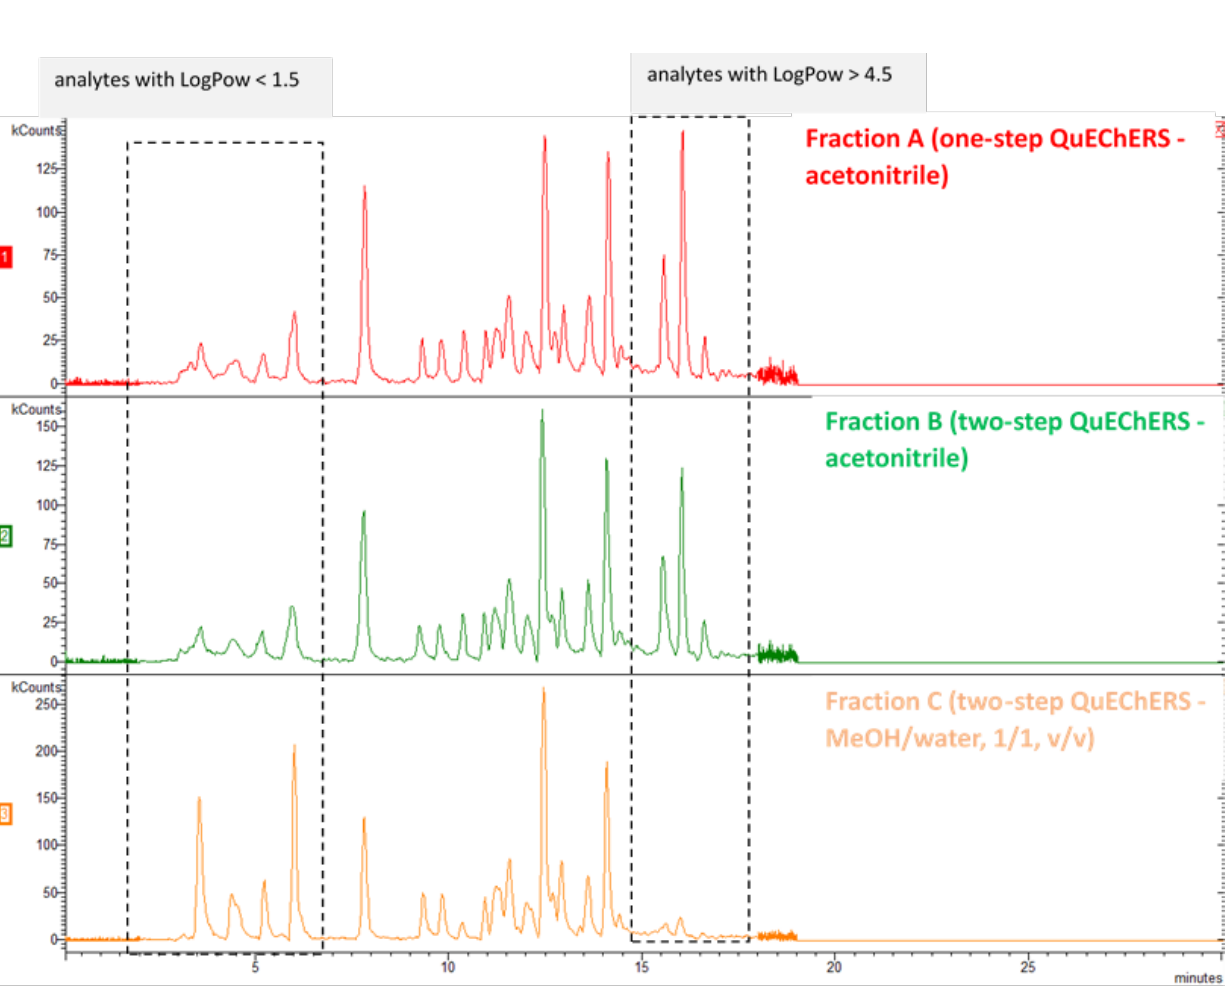
Figure 3. Comparison of TIC chromatograms of Fraction A (red line), Fraction B (green line) and Fraction C (orange line) of a sludge sample fortified with all the analytes at 10 ng/g and internal standard at 100 ng/g.